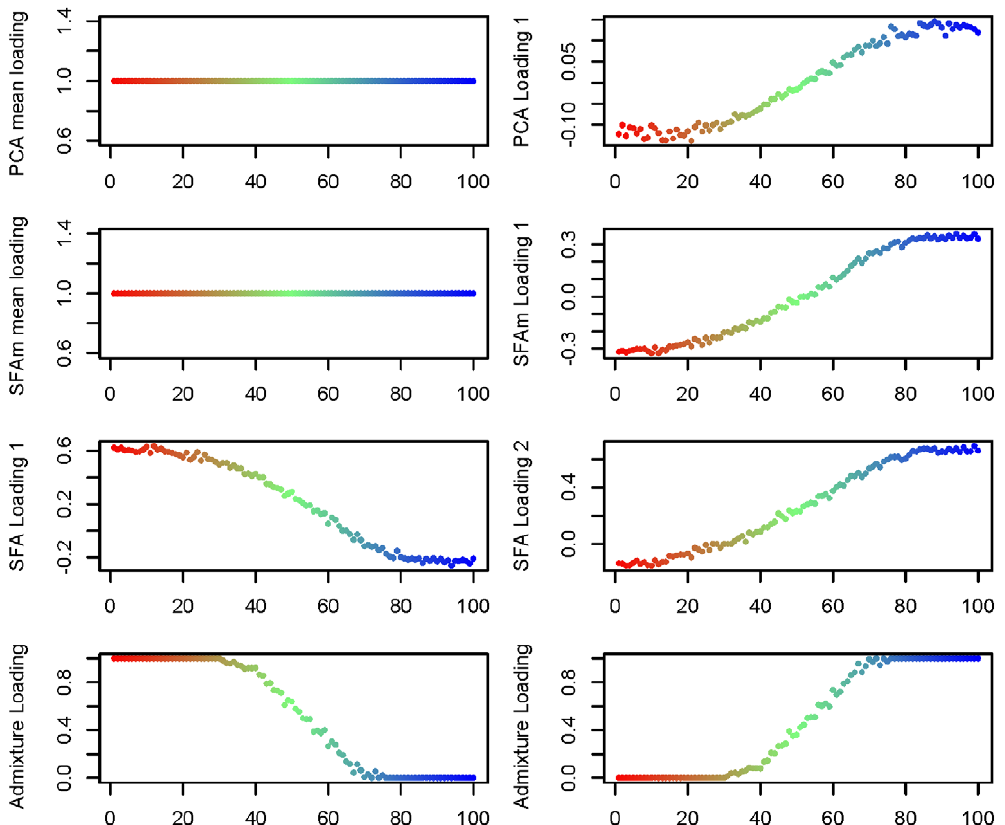
Figure 4. Estimated factor loadings from PCA, SFAm, SFA, and ADMIXTURE for the 1-D isolation-by-distance simulation. In each plot the individuals are colored and ordered along the x -axis by location in the 1-D habitat.